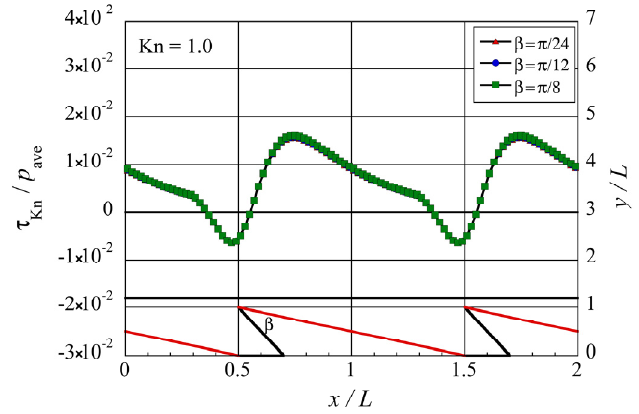
Figure 8. Distributions of the local tangential Knudsen stress due to molecules coming from the oblique side of the modified ratchet microstructure for different tip angles 𝛽 at Kn = 1 .